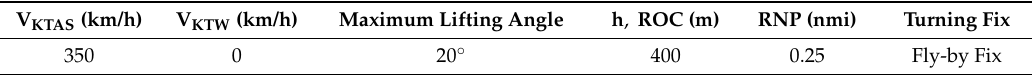
Table 1. The UAV flight parameters.